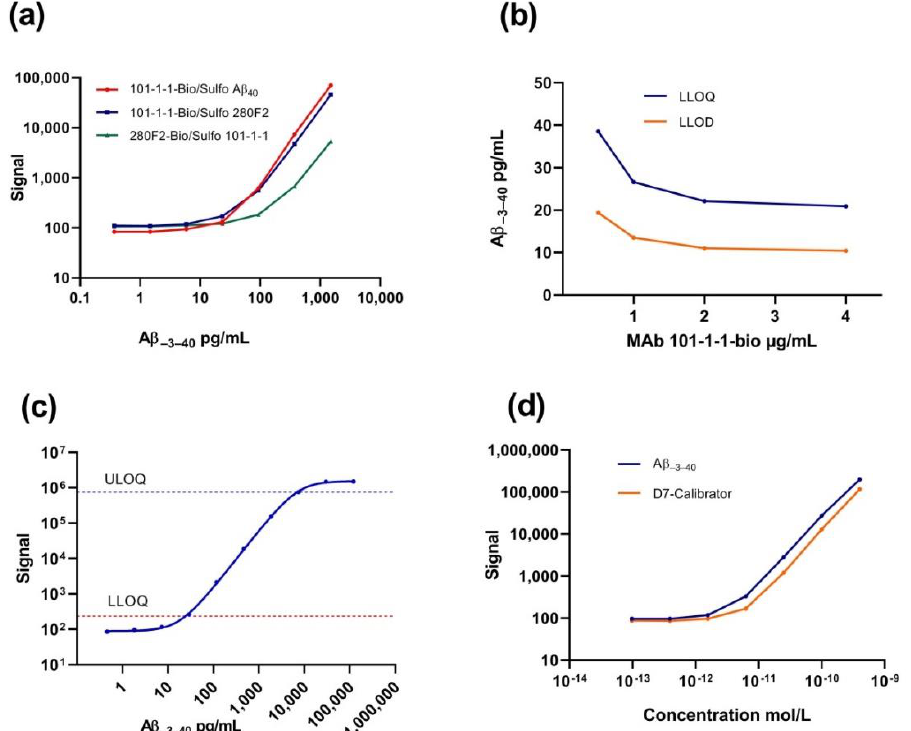
Figure 5. Assessment of different antibody combinations, capture antibody titration, quantitative assay range, and comparison of alternative calibrators. ( a ) Comparison of sandwich immunoassay variations employing mAb 101-1-1-biotin or 280F2-biotin for capture and SULFO-TAG A β 40 , SULFO-TAG 280F2, or SULFO-TAG 101-1-1 for detection. The tested antibody combinations are indicated. ( b ) lower limit of detection (LLOD) and lower limit of quantification (LLOQ) of the A β − 3–40 immunoassay as functions of the 101-1-1-biotin capture antibody concentration. ( c ) Determination of the quantitative assay range. Upper limit of quantification (ULOQ) and LLOQ were calculated from the signals obtained with an extended fourfold calibrator dilution series plus blank (zero calibrator). ( d ) Comparison of dose–response curves obtained with synthetic A β − 3–40 and D7-Calibrator.